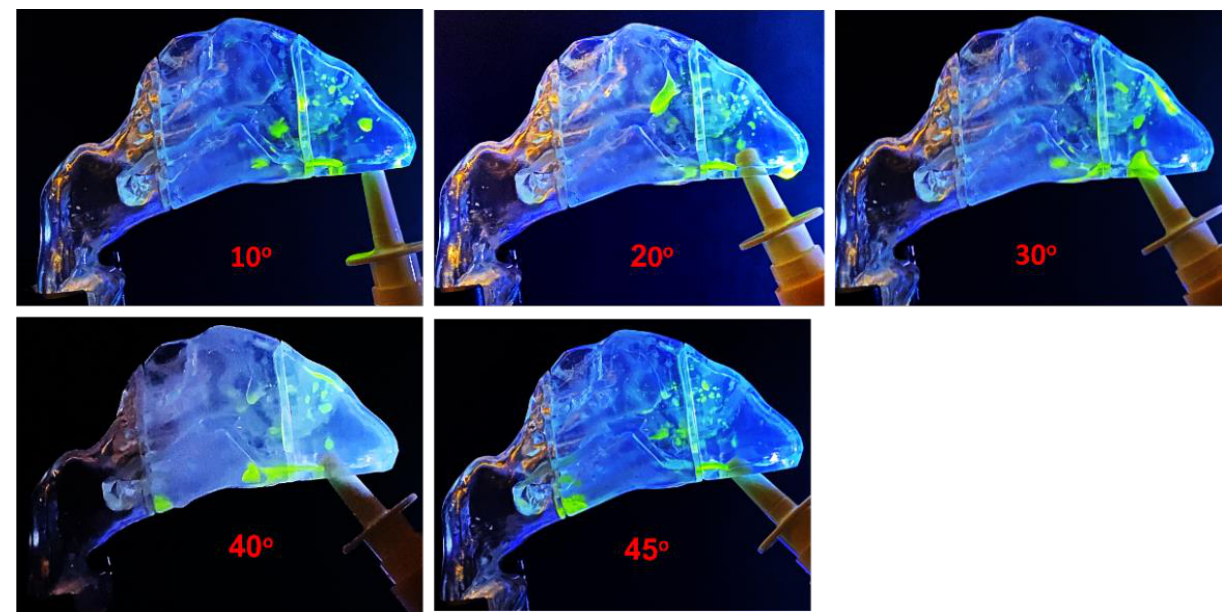
Figure 3. Nasal spray deposition distribution using the unidirectional delivery method for different administration angles: 10°, 20°, 30°, 40°, and 45°.